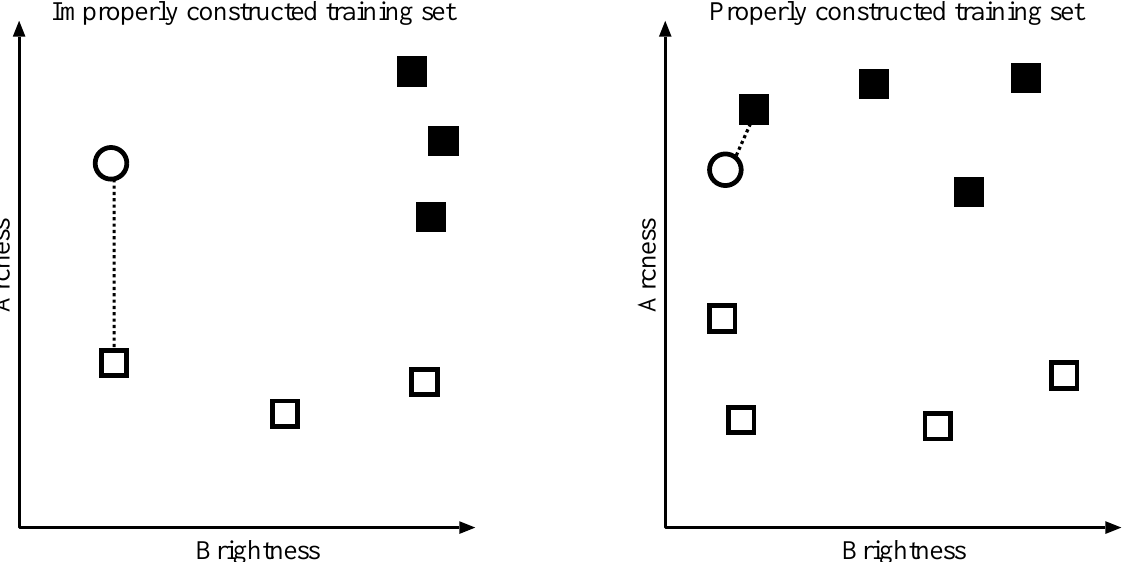
Fig. 5. Improperly constructed (left) and properly constructed (right) training set. The white circle denotes the query image while the squares denote the training set images with the black square being an image with an arc and the white square is one without an arc. The query image is connected to the nearest training set image by a dotted line. In the left panel, the query image is incorrectly classified as a non-arc. In the right panel, the training set has enough representative samples of arcs and the query image is correctly classified.